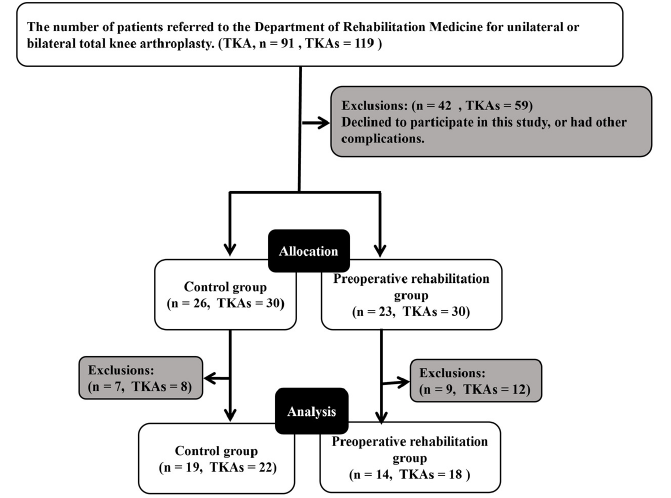
Figure 1. Flow diagram of patient selection and progress through the phases of the study. TKA, total knee arthroplasty.